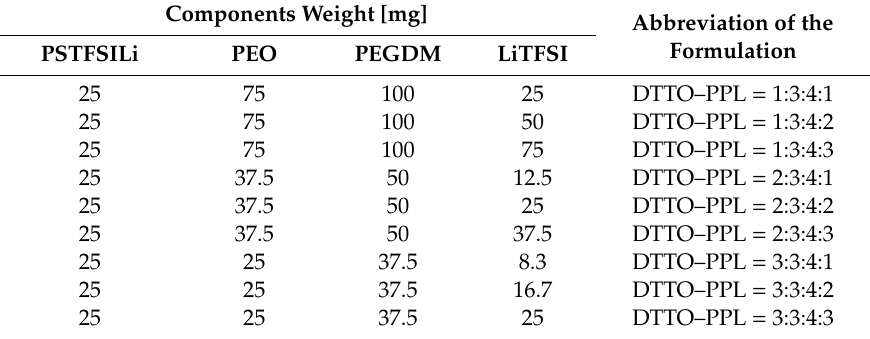
Table 4. Formulations of the SPE films with various weight ratios of PSDTTOLi and LiTFSI. Components Weight [mg] Abbreviation of the FormulationPSTFSILi